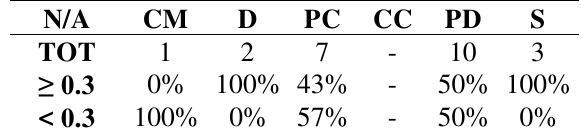
Table 2. Correspondence between data grouped by N/A ratio and CALIPSO derived aerosol types.